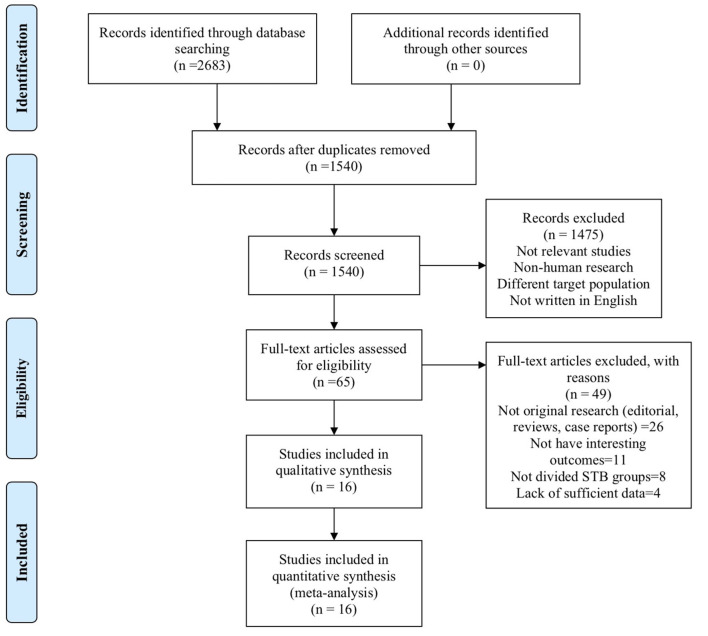
Flow chart of study selection.